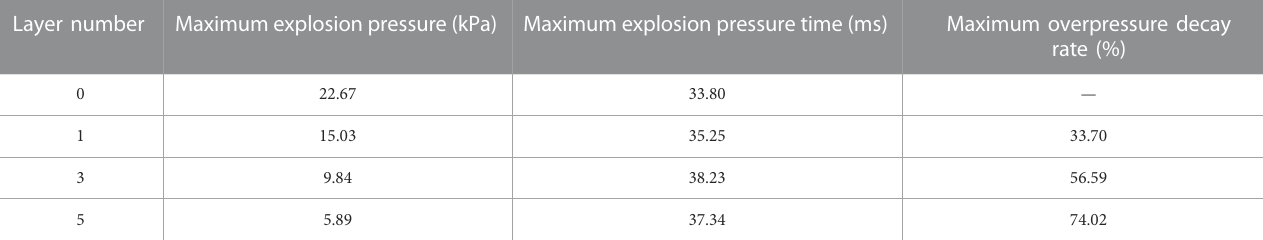
TABLE 4 Characteristic values of fl ame explosion